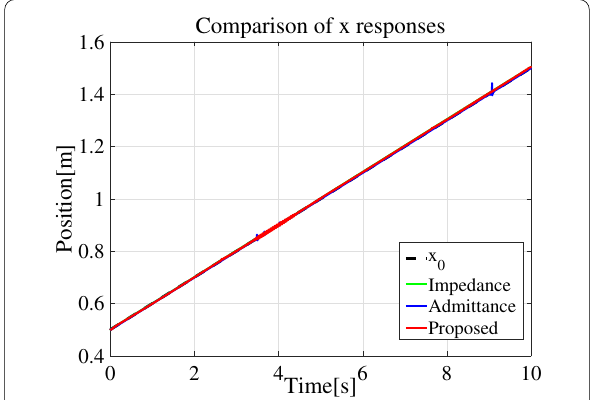
Fig. 12 Transient response of the x coordinate of endpoint